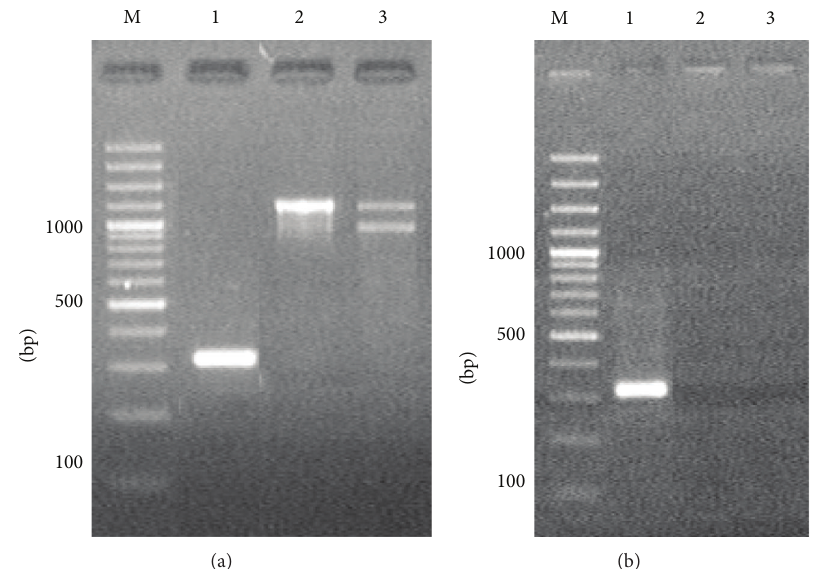
Figure 4: Electrophoregrams of the amplification products of the nucleotide sequences of parC (1), ftsZ (2), and A23LR (3) of Acholeplasma laidlawii PG8, which were obtained by PCR using the total DNA (as a template) isolated from the cells (a) and extracellular vesicles (b) of A. laidlawii PG8R. M: molecular weight